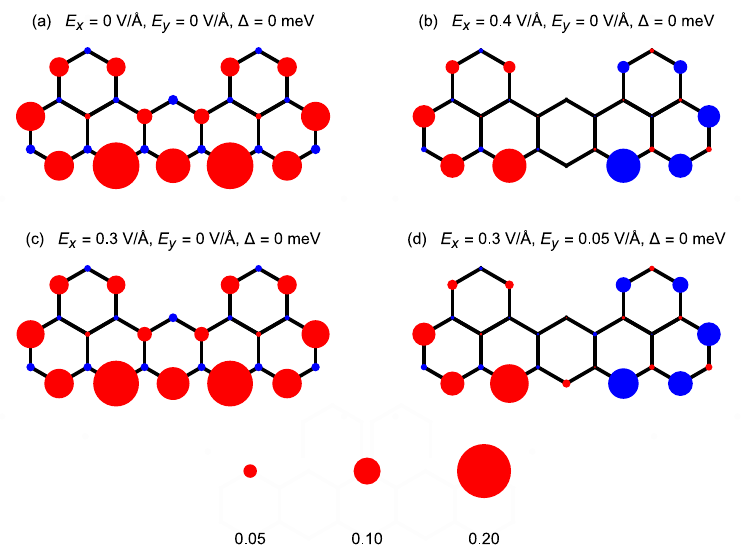
Figure 7. Spin density distribution across the nanostructure for various values of the electric field, in the absence of the exchange energy: E x = 0, E y = 0 ( a ); E x = 0.4 V/Å, E y = 0 ( b ); E x = 0.3 V/Å, E y = 0 ( c ); E x = 0.3 V/Å, E y = 0.05 V/Å ( d ). Red and blue colours mark two antiparallel spin orientations. The radius of the circle is proportional to the spin density (the scale is shown at the bottom of the